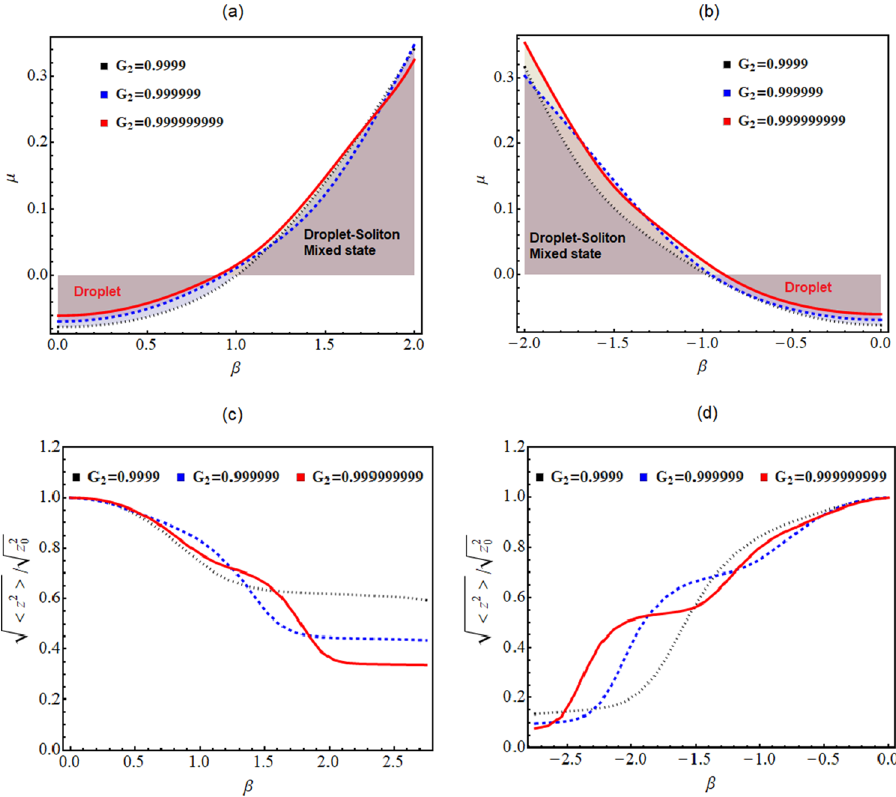
Figure 3. ( a , b ) Change in energy w.r.t to the variation of the BOL potential depth ( β ) are plotted here for different EMF interactions strengths. ( c , d ) Variation of the rms size of the droplets with the tuning of β . Here, solid red line, blue dashed, and black dotted lines denote the energy variation as a function of BOL potential 0.999999999 , 0.999999, and 0.9999, respectively. Further, the magnitude of physical strengths for G 2 = 0.84 , G 1 1 , E 1 , k 2 / 9 . The spatial coordinate is scaled by the oscillator parameters: γ 0 = = − = = −